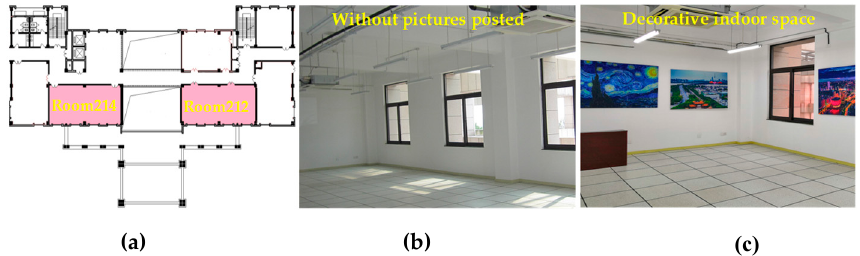
Figure 8. The decorated experimental rooms in a building: ( a ) location of rooms, ( b ) undecorated room, and ( c ) decorated